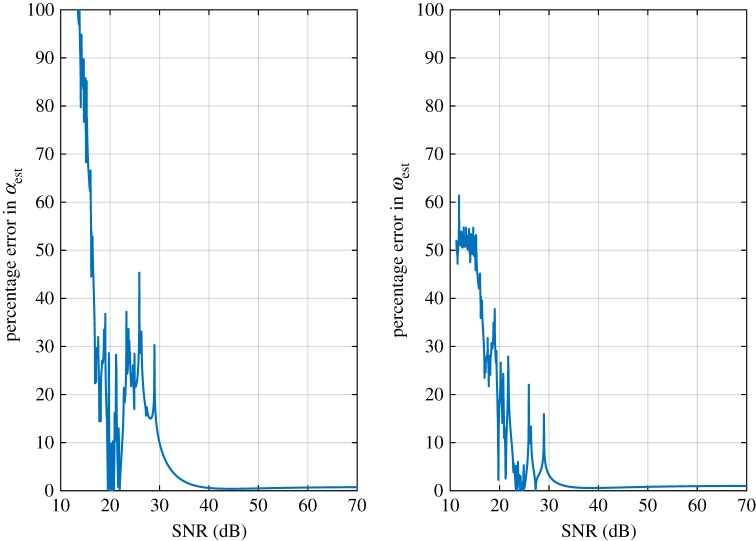
Absolute values of percentage error in αest and ωest versus SNR.